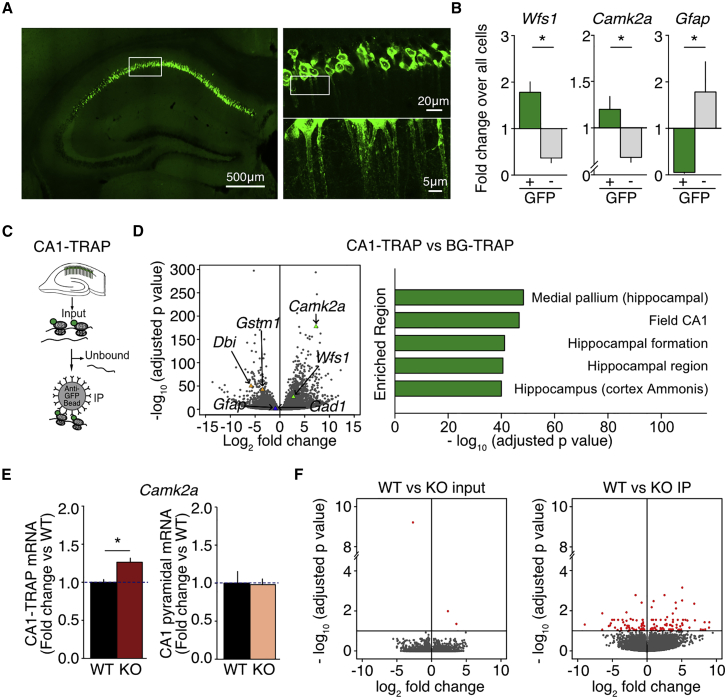
TRAP-Seq Identifies Differentially Translating mRNAs in Fmr1−/y CA1 Pyramidal Neurons(A) Confocal images show selective expression of GFP-L10a in pyramidal neurons of the CA1 region.(B) GFP-positive (GFP+) cells in CA1-TRAP hippocampus are enriched for CA1 neuronal markers (Camk2a: GFP− 0.683 ± 0.05, GFP+ 1.200 ± 0.138, ∗p = 0.0046, n = 12; Wfs1: GFP− 0.370 ± 0.104, GFP+ 1.781 ± 0.224, ∗p < 0.0001, n = 9) and depleted of glial markers (Gfap: GFP− 1.784 ± 0.650, GFP+ 0.054 ± 0.022, ∗p = 0.0218, n = 12) compared to all cells.(C) Schematic representation of TRAP shows isolation of translating ribosomes (IP) from Input using anti-GFP coated beads.(D) Differentially expressed genes in CA1-TRAP versus Bergmann glia (BG)-specific TRAP are enriched in CA1 neuronal markers according to the Allen Brain Atlas enrichment algorithm.(E) Camk2a is significantly increased in Fmr1−/y versus WT CA1-TRAP IP (WT = 1.00 ± 0.037, KO = 1.26 ± 0.054, ∗p = 0.0004, n = 14). Total Camk2a is equivalent in Fmr1−/y and WT FACs-isolated CA1 pyramidal neurons (WT = 1.00 ± 0.059, KO = 0.855 ± 0.047, p = 0.0734, n = 9).(F) TRAP-seq analysis reveals differential expression of 121 genes in the IP fraction and 3 genes in the Input fraction (FDR < 0.1). n = number of littermate pairs. Error bars indicate SEM.